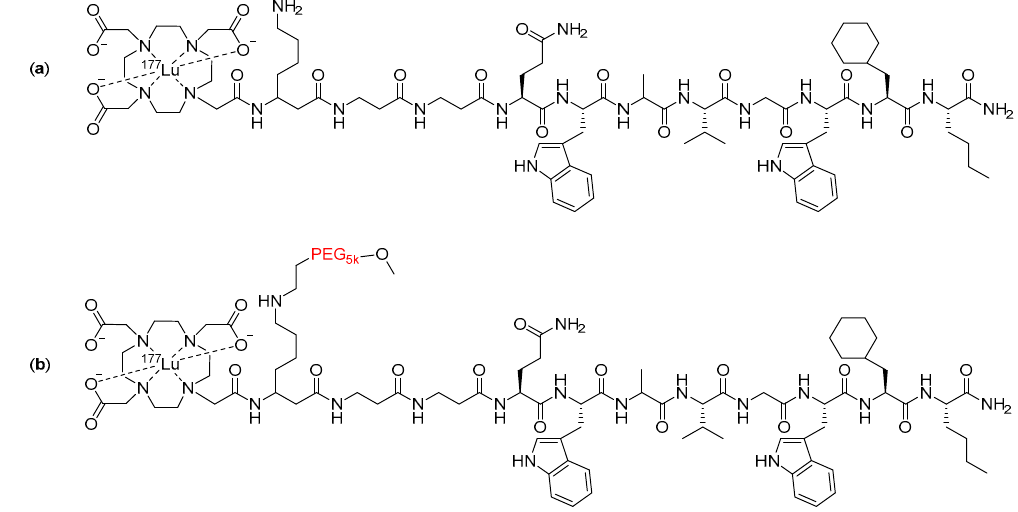
Figure 17. Structure of ( a ) unmodified and ( b ) modified bombesin peptide radiotherapeutics investigated by Dapp et al., with the PEG linker modification highlighted in red [109].